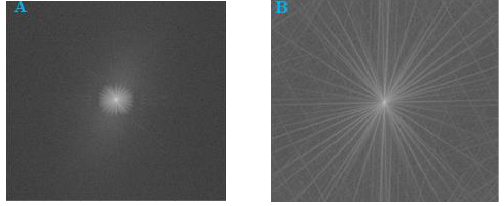
Figure 3. Two examples of photogrammetric (A) and PS (B) depth transformation in Fourier domain for Object